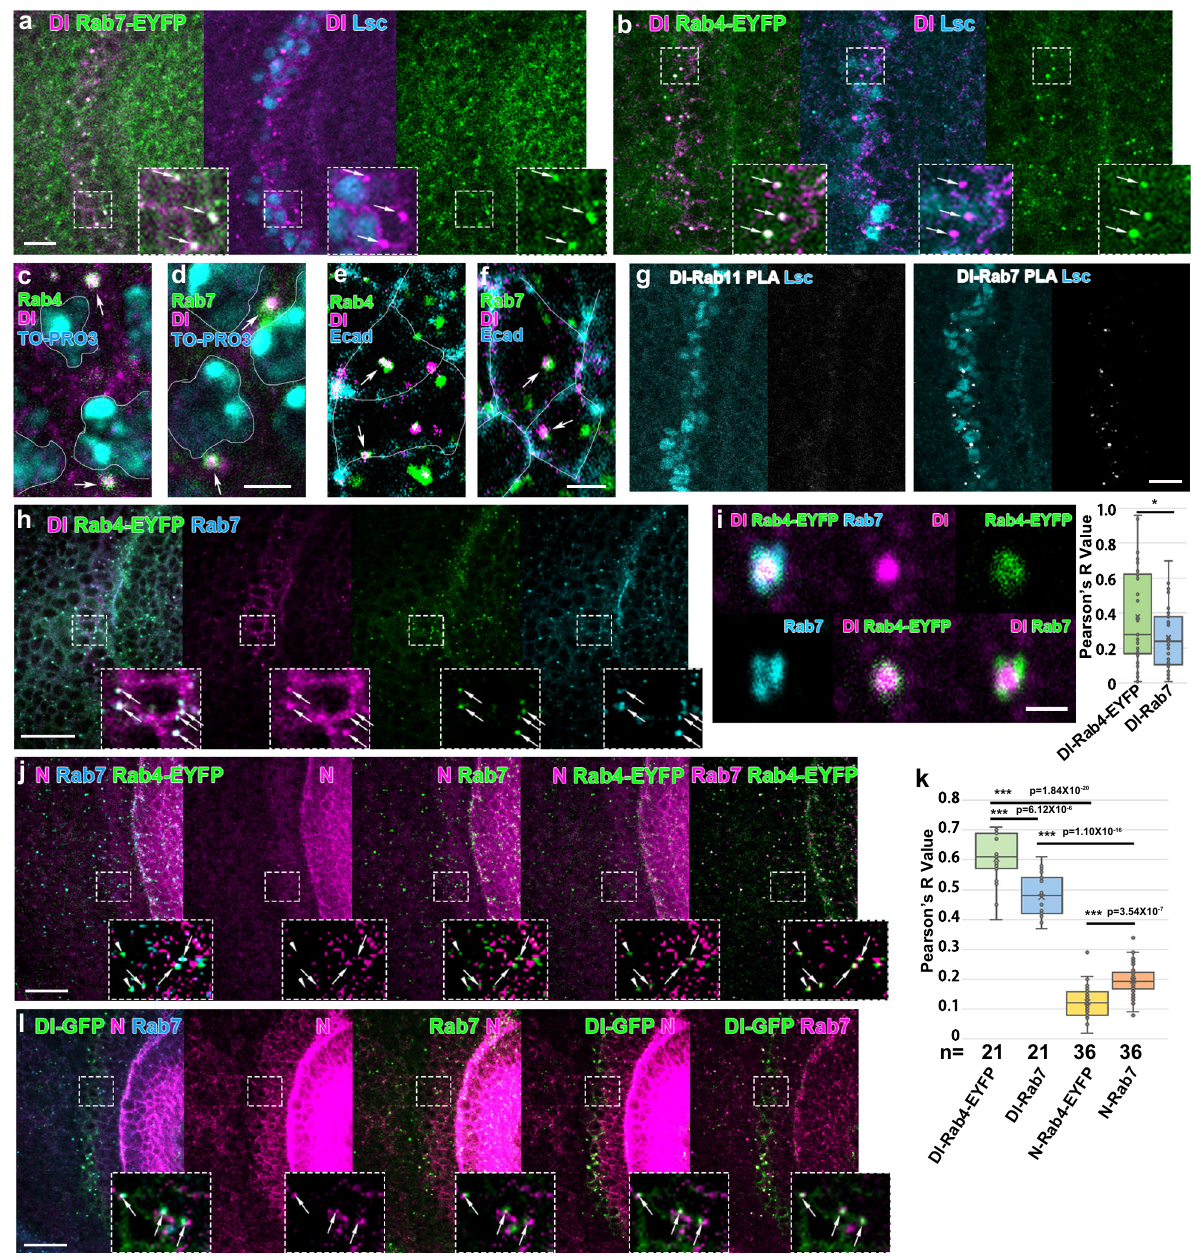
Fig. 3 Delta and Notch differentially colocalize with Rab7 and Rab4. a , b Dl (magenta) is colocalized with Rab7-EYFP (green in a ) and Rab4-EYFP (green in b ) at the wavefront (Lsc, blue) as indicated by arrows. c – f Dl (magenta) is colocalized with Rab7 and Rab4 outside the nucleus (TO-PRO3, blue) and inside the plasma membrane (Ecad, blue) as indicated by arrows. Nuclei and membranes are outlined by white lines. g Proximity ligation assay (PLA) demonstrates the interaction between Rab7 and Dl in vivo (white dots) at the wavefront (Lsc, blue). The interaction between Rab11 and Dl is not detected. h Dl (blue), Rab4-EYFP (green), and Rab7 (magenta) colocalize in the same puncta. i The colocalization of Dl, Rab7, and Rab4-EYFP is visualized in the left panels and quanti fi ed in the right panel. Pearson ’ s R values are compared for Dl with Rab4-EYFP and Rab7 ( p = 0.035 (* p < 0.05), two-sided t test, n = 35, number of quanti fi ed areas). j N is occasionally colocalized with Rab7 and Rab4-EYFP (arrows). k Pearson ’ s R values are compared for Dl and N with Rab4- EYFP and Rab7 ( p = 6.12 × 10 − 6 , 1.84 × 10 − 20 , 1.10 × 10 − 16 , and 3.54× 10 − 7 for Dl-Rab4/Dl-Rab7, Dl-Rab4/N-Rab4, Dl-Rab7/N-Rab7, and N-Rab4/N-Rab7, respectively (*** p < 0.001), two-sided t test, n = 21 (Dl) and 35 (N), number of quanti fi ed areas). l N is occasionally colocalized with Dl-GFP and Rab7 (arrows). Signals for N are enhanced. The dotted boxes are enlarged in the right bottom panels ( a , b , h , j , l ). Scale bars indicate 10 μ m in ( a , b , g , h , j , l ), 2 μ m in ( c – f ), and 1 μ m in ( i ). Cross, mean; center line, median; box limits, upper and lower quartiles; whiskers, 1.5× interquartile range in the box plots ( i , k